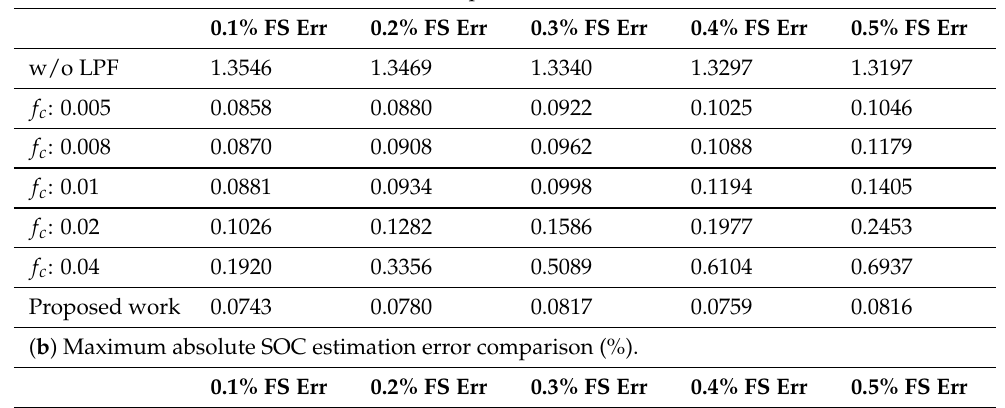
Table 3. SOC estimation performance comparison in cases of various scale measurement noises using multiple cutoff frequency